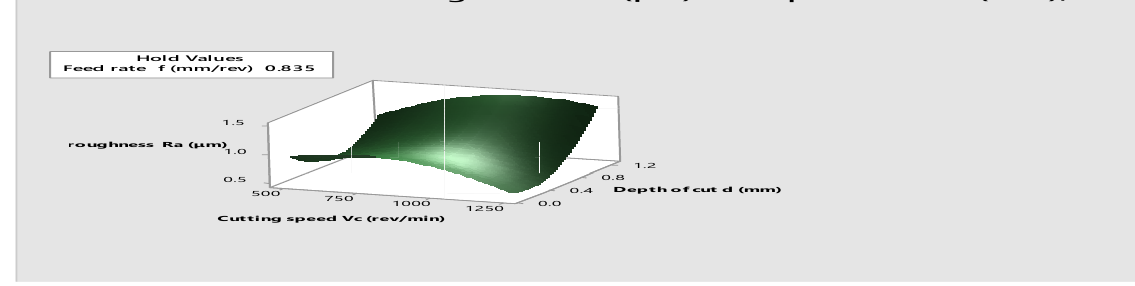
Figure 11: 3D surface graph for surface roughness with JBCF